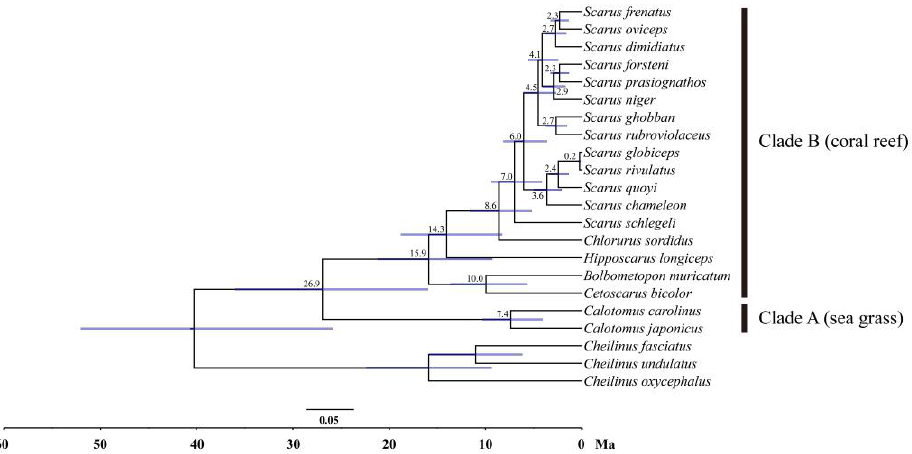
Figure 9. Divergence time estimation of the parrotfishes derived from MCMCTree analysis. Numbers at nodes indicate estimated age. Blue bars represent 95% credible age intervals for each node.